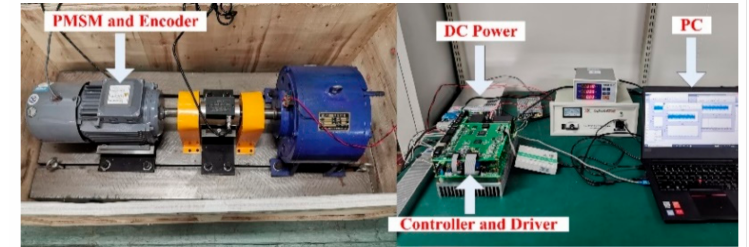
Figure 10. PMSM servo system setups.